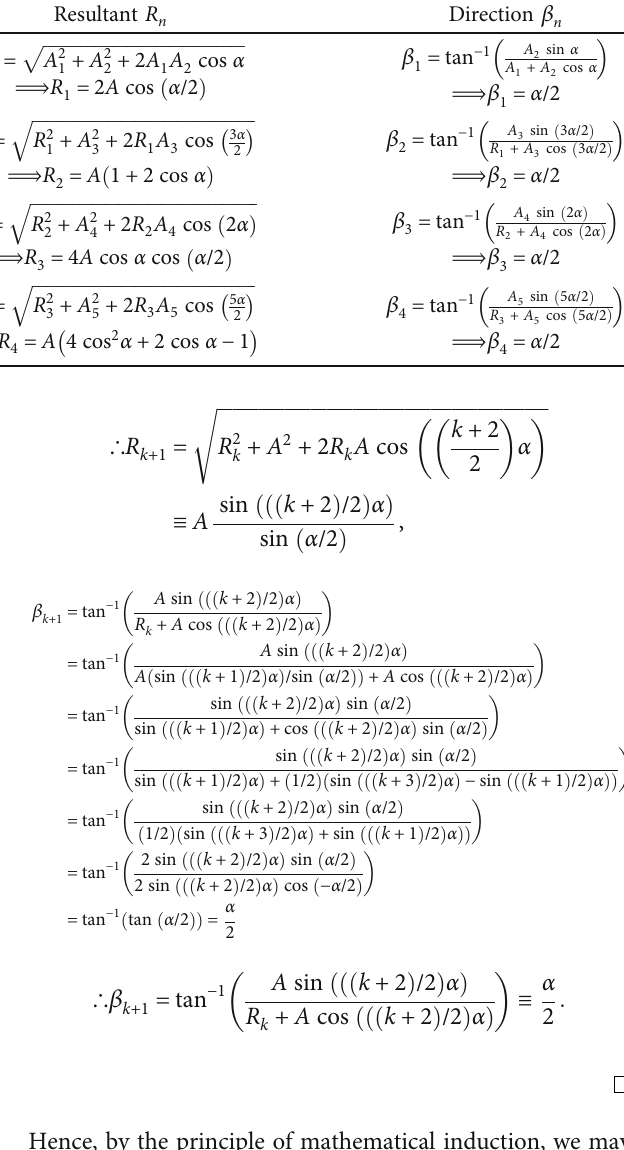
Table 2: n = f 1, 2, 3, 4 g iterations of the parallelogram law of vector addition. Iteration number n Summed